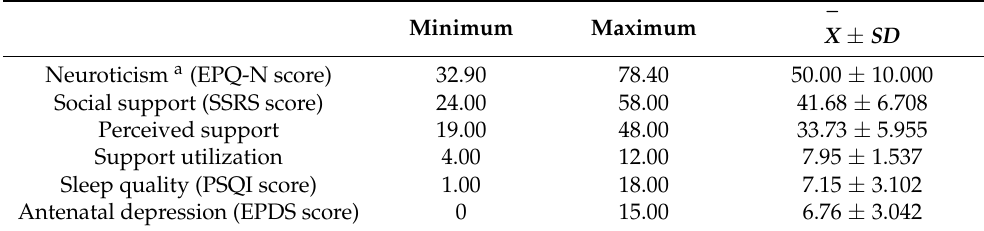
Table 1. Descriptive statistics of neuroticism, social support, sleep quality, and antenatal depression ( n =